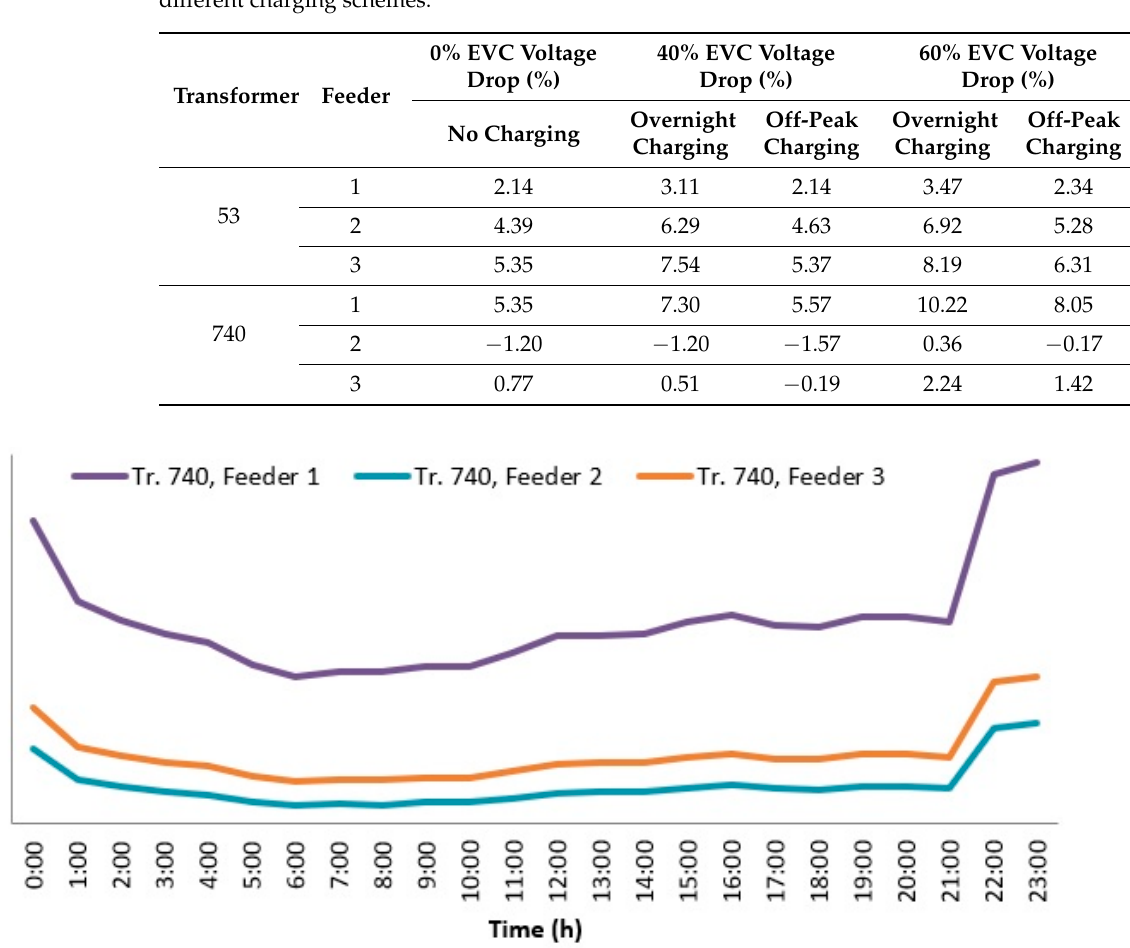
Figure 16. Load profiles of Transformer 740 in summer with 60% EVC and off-peak charging.